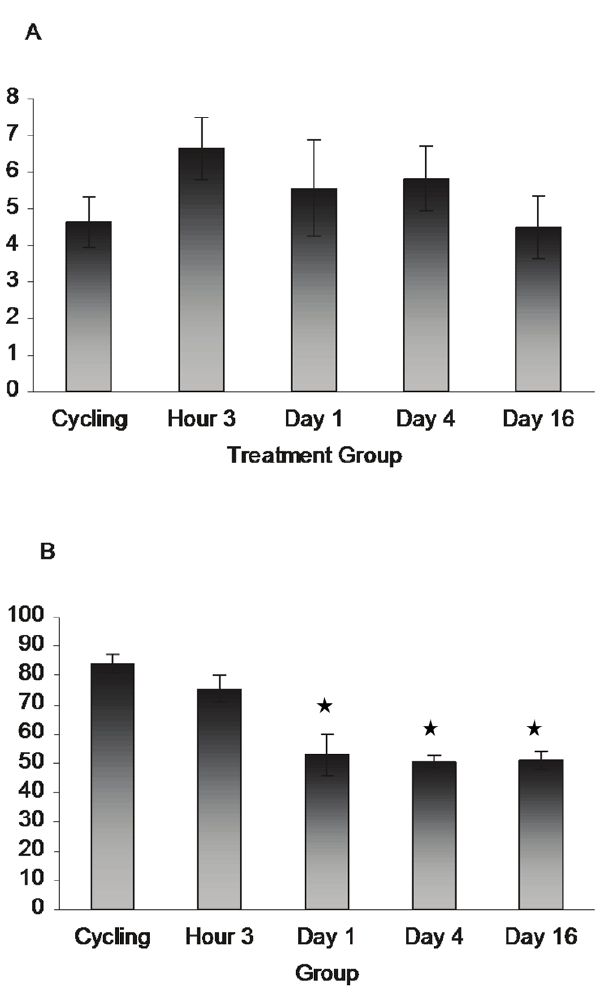
D16 n=6; MPOA: cycling n=5, H3 n=4, D4 n=4, D16 n=5)